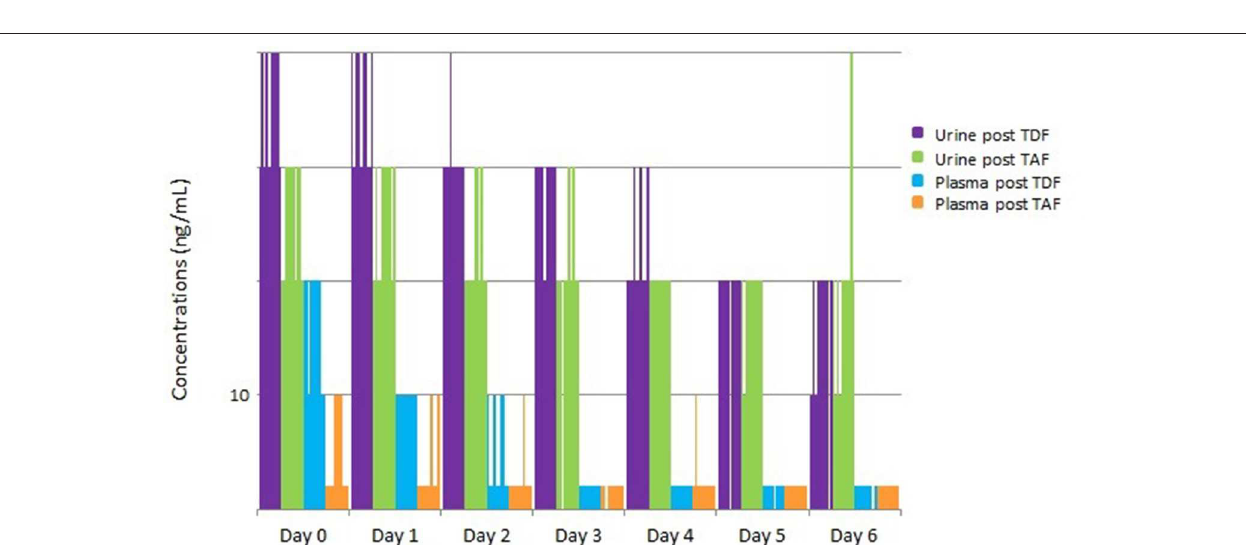
FIGURE 2 | Cohor t 2: Urine/Plasma TFV Concentrations following a Single Dose of FTC/TAF in 10 HIV-Participants. TFV, tenofovir; FTC/TAF, emtricitabine/tenofovir alafenamide; TAF, tenofovir alafenamide; ng/mL, nanograms per millimeter.